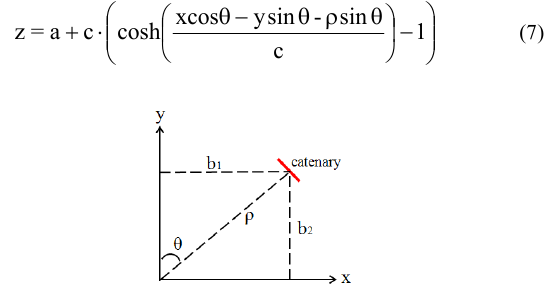
Figure 7. Relationship between b1, b2, θ and